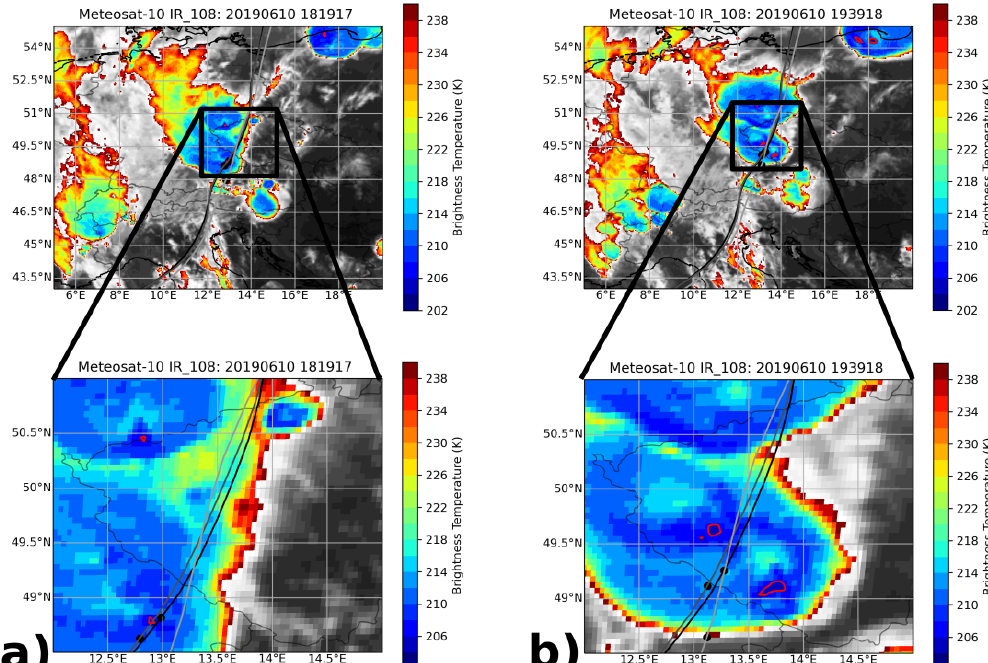
Figure A2. Same as Fig. 11 but for a different point in time. Air mass trajectories initiated at different pressure levels (144, 153, and 155hPa) are shown with gray to black lines. Air masses with BT < 209K are marked with pink contours. Panels (a) and (c) show the satellite image at 18:19UTC and panels (b) and (d) at 19:39UTC on 10 June 2019.